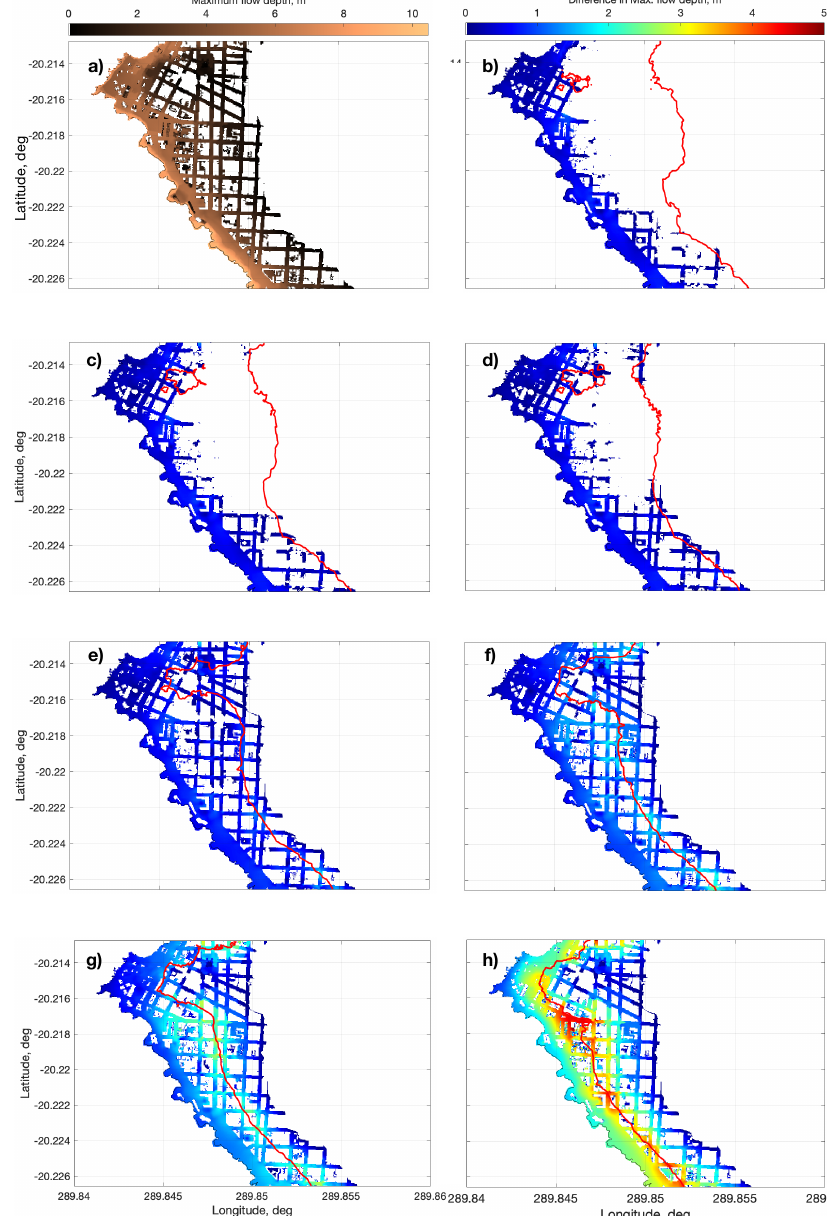
Figure 2. Inundation extent comparison between the DSM model, including resistant buildings, and a DTM model, on Grid-L3b. ( a ) Inundation extent and maximum flow depth of the reference, DSM model; ( b – h ) Difference in flow depth extrema between DSM and DTM-CRM, using the maximum grid resolution, R 1 . ( b ) n = 0.025; ( c ) n = 0.04; ( d ) n = 0.06; ( e ) n = 0.10; ( f ) n = 0.15; ( g ) n = 0.20; ( h ) n = 0.40. Red line denotes the inland limit of the maximum inundation of each DTM-CRM